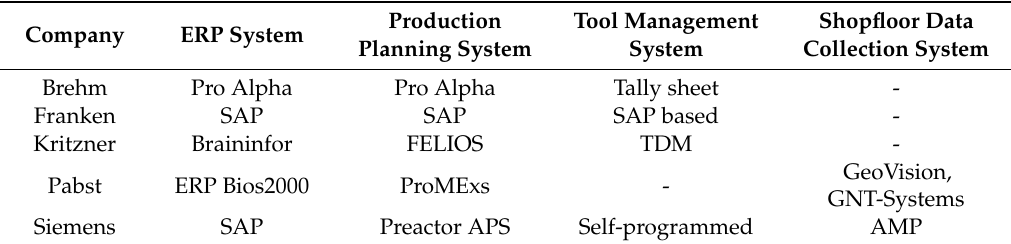
Table 8. IT system landscape of the OBerA